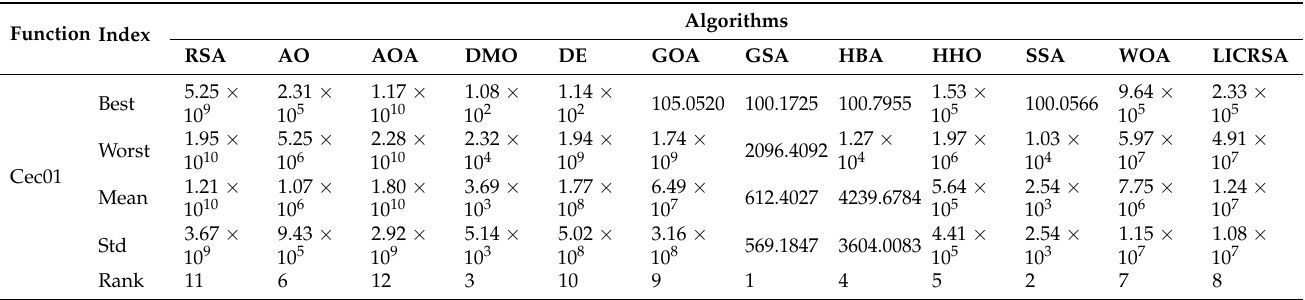
Table 4. Results of LICRSA and MH algorithms on